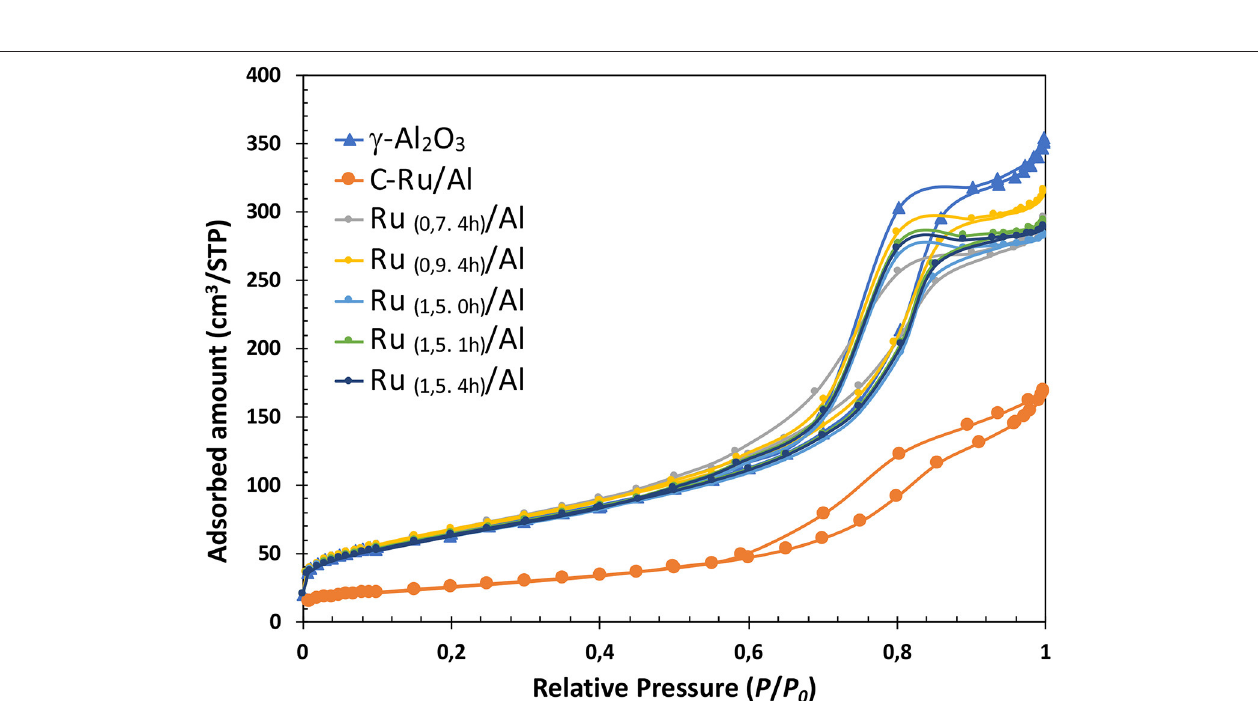
FIGURE 1 | N 2 adsorption isotherms ( − 196 ◦ C) of Al 2 O 3 , Ru/Al commercial and synthesized.